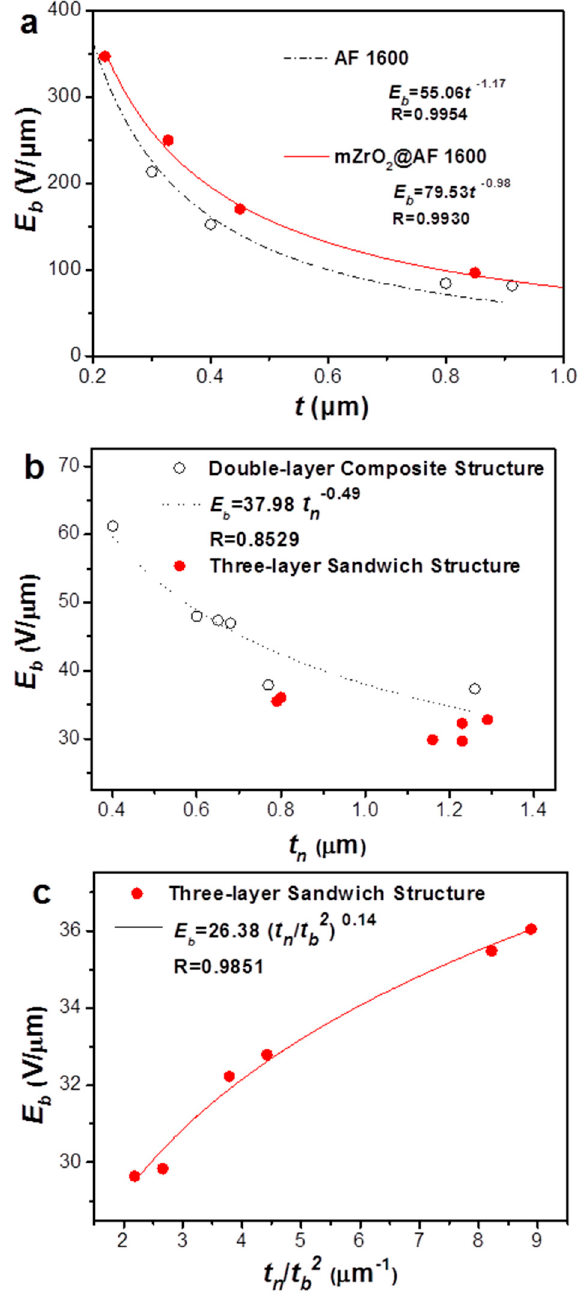
Figure 8. Mathematical relationship between thickness and breakdown field strength ( E b ) of ( a ) monolayer AF 1600 and mZrO 2 @AF 1600 film; ( b ) double-layer and ( c ) three-layer, respectively. Note that, t is total thickness, t n is thicknesses of the mZrO 2 @AF 1600 layer (mZrO 2 content: 5.35 vol %) and t b is the thicknesses of the bottom AF 1600 layer.